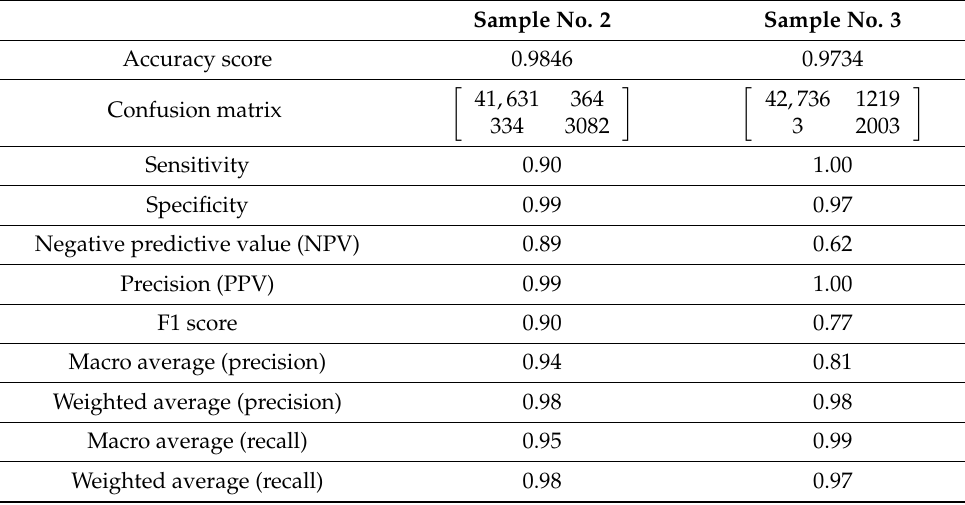
Table 3. Performance of the selected random forest model on two additional testing samples.